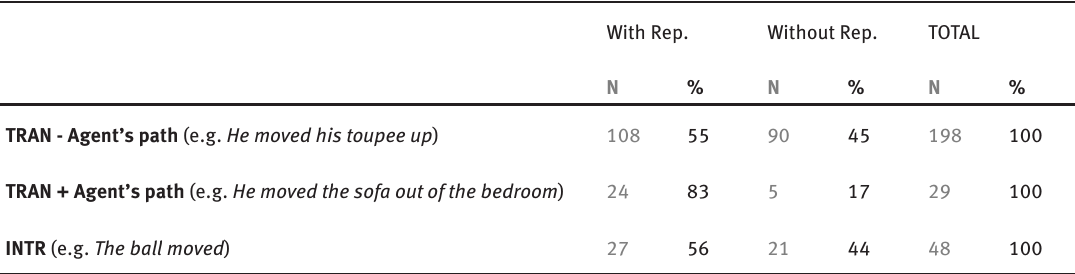
Table 8. Frequencies of representational gestures occurring with the causative-inchoative alternation with and without the Agent’s path